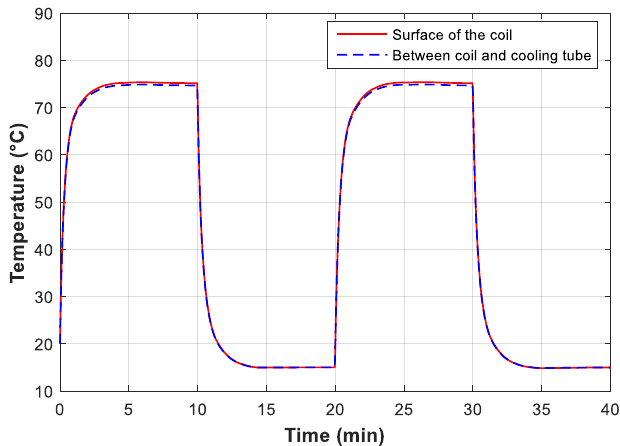
Figure 17. Temperature profiles obtained from the simulation.